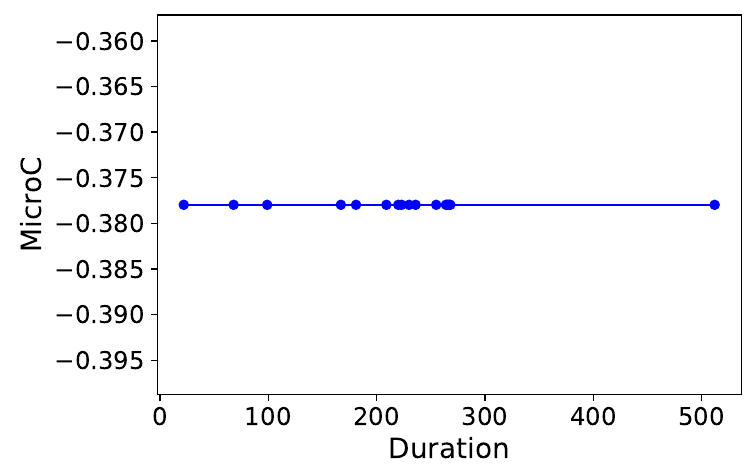
Figure A21. Normalized categorical carbon source (MicroC) for Reactor 2.